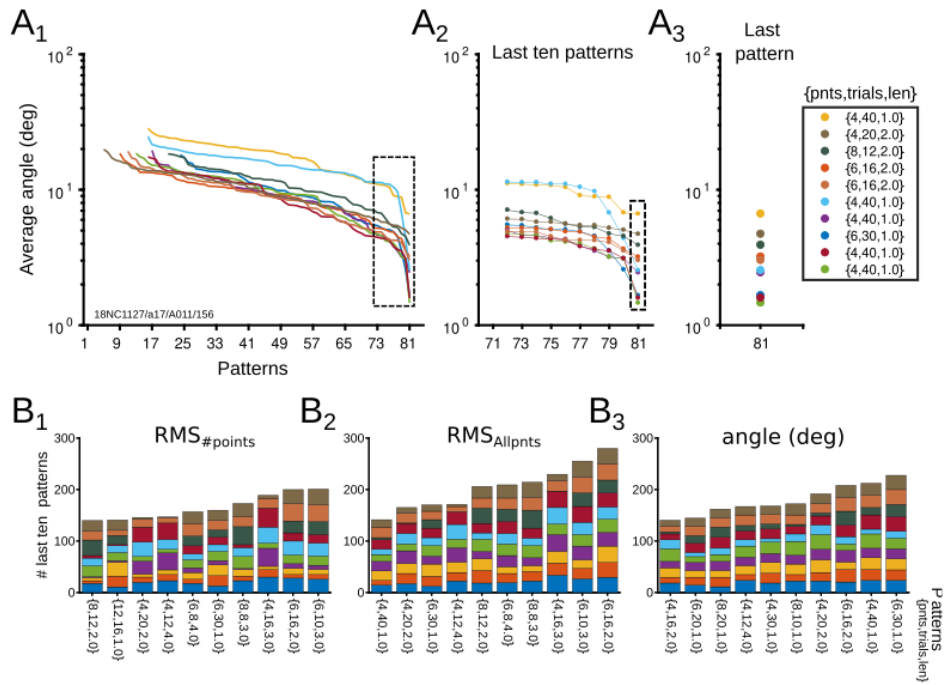
Figure 6. Experimental patterns with the best performance. ( A1 – A3 ) Representative example for angle errors sorted from the worst to the best pattern performance. Best patterns are those minimizing the error. ( A1 ) Errors across all patterns, ( A2 ) Errors of the last ten patterns, ( A3 ) Last pattern that minimizes most of the error. ( B1 – B3 ) Histogram showing the most representative patterns that minimize the error for all spacing scales. Data was taken from last ten patterns ( A2 ). Last ten pattern errors for RMS #points ( B1 ), RMS Allpnts ( B2 ), and angle difference between vectors ( B3 ).